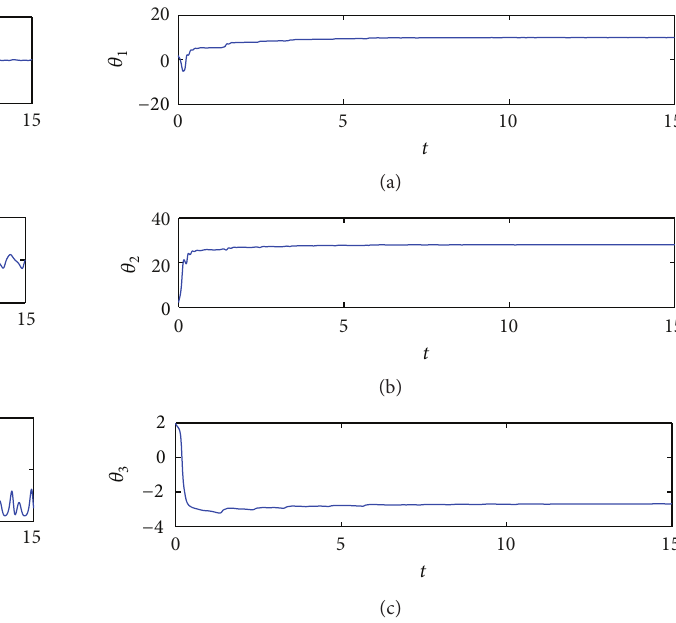
Figure 14: Time responses of the control input in Example 2.